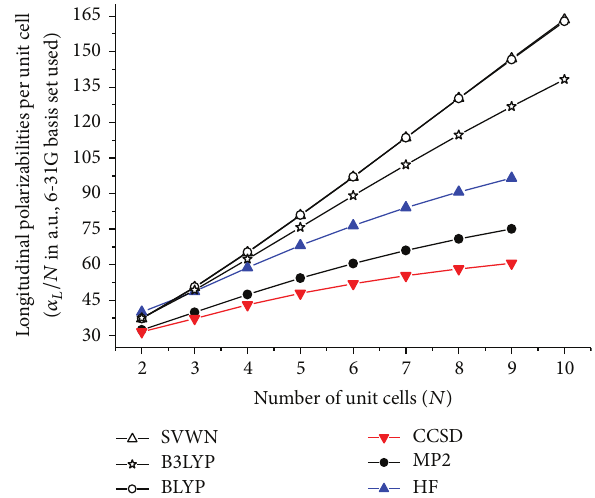
Figure 1: Longitudinal polarizabilities per unit cell (𝛼 𝐿 /𝑁) of polyenes (in a.u.) obtained by various quantum chemical methods with 6-31G basis set.